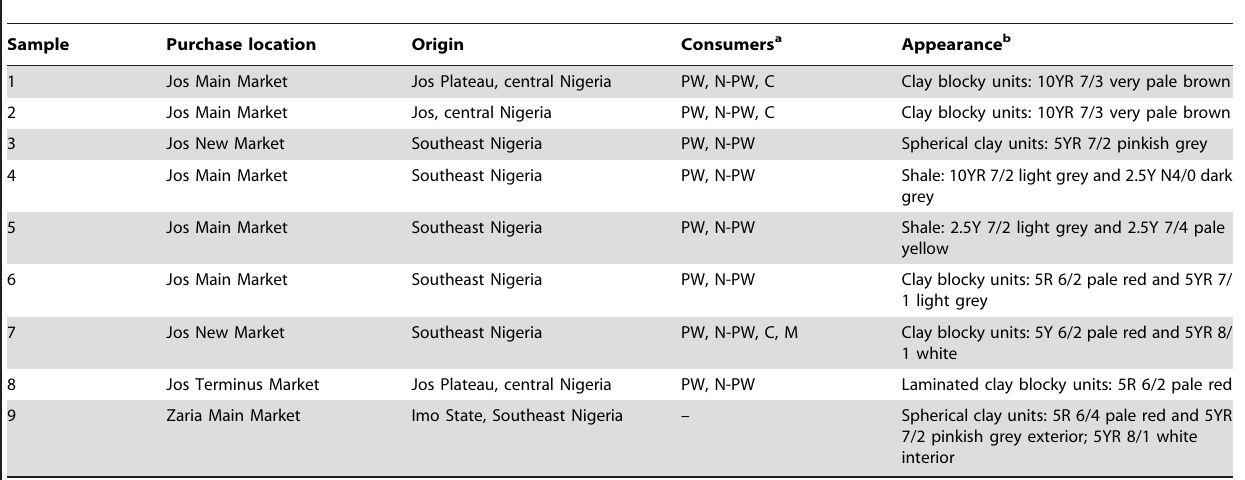
Table 3. Place of purchase, general area of origin, consumers and appearance of the geophagical materials.